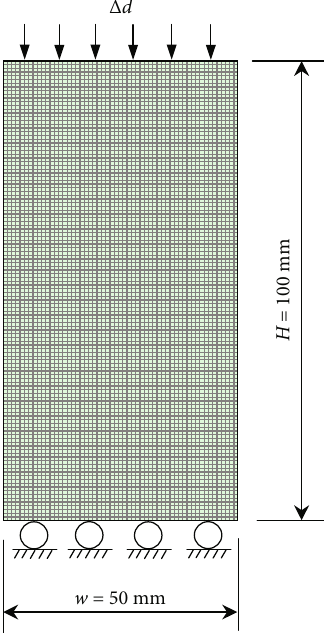
Figure 3: Numerical model of uniaxial compression of rock